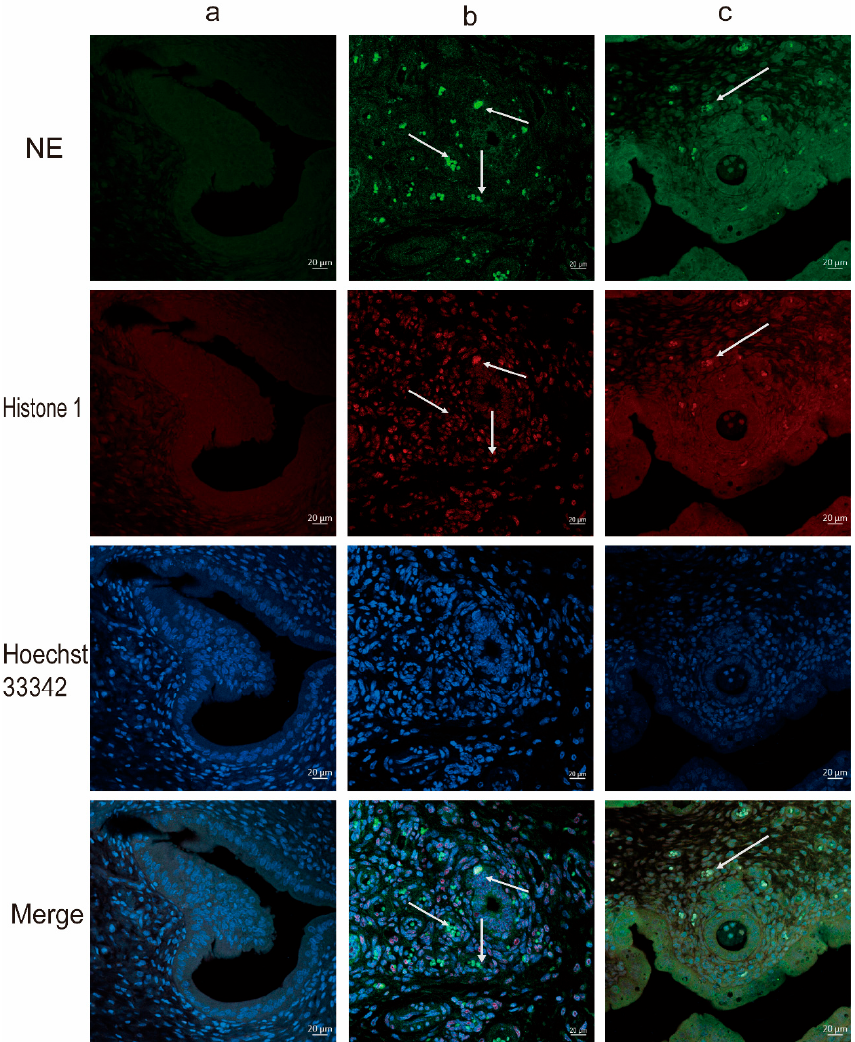
Figure 3. Neutrophil extracellular traps (NETs) in LPS-induced endometritis uterus but absent in healthy tissue, and decreased by treating with Cl-amidine. ( a ): control group. ( b ): the LPS group. ( c ): the LPS + Cl-amidine group. NE stands for neutrophil elastase. The red scale length is 20 um. The arrows are showing the NETs